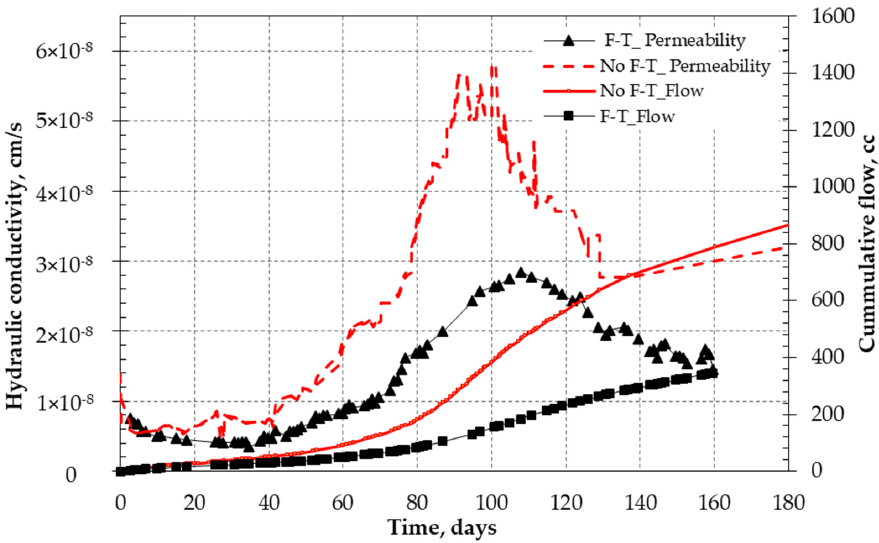
Figure 4. Hydraulic conductivity and cumulative flow for 15%B before and after freeze-thaw cycles.